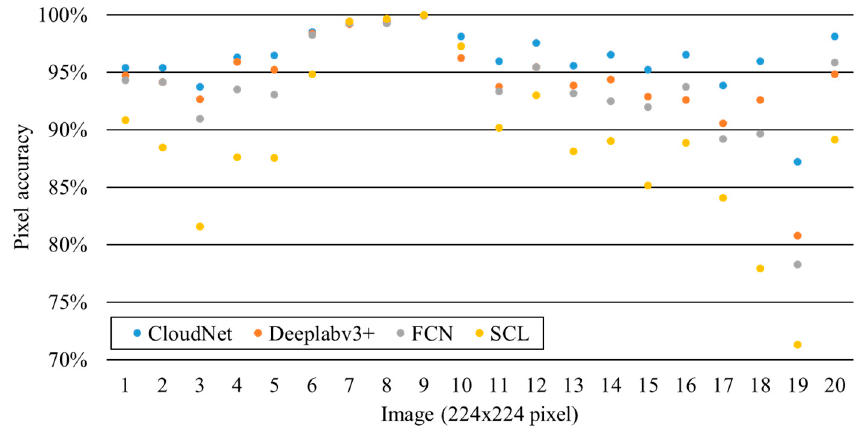
Figure 10. Comparison of pixel accuracy obtained from the SCL, the FCN, Deeplab v3+, and CloudNet for all 20 scenes (1,003,520 pixels in total).